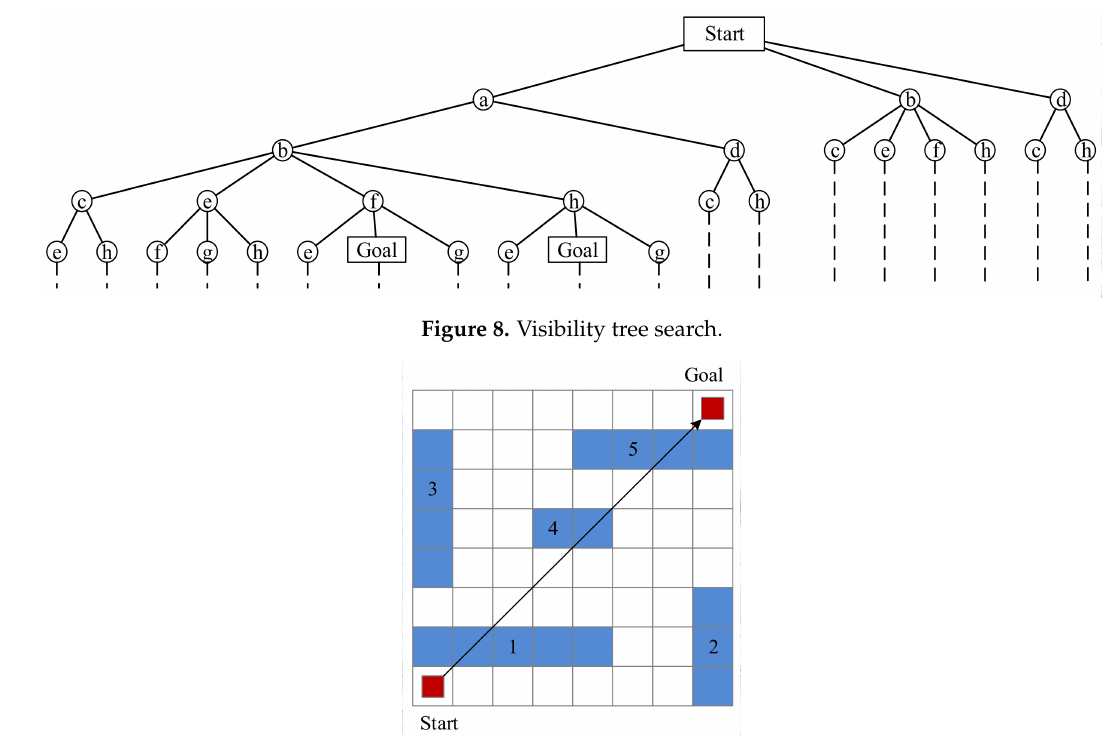
Figure 9. Obstacles in collision-free shortest path planning